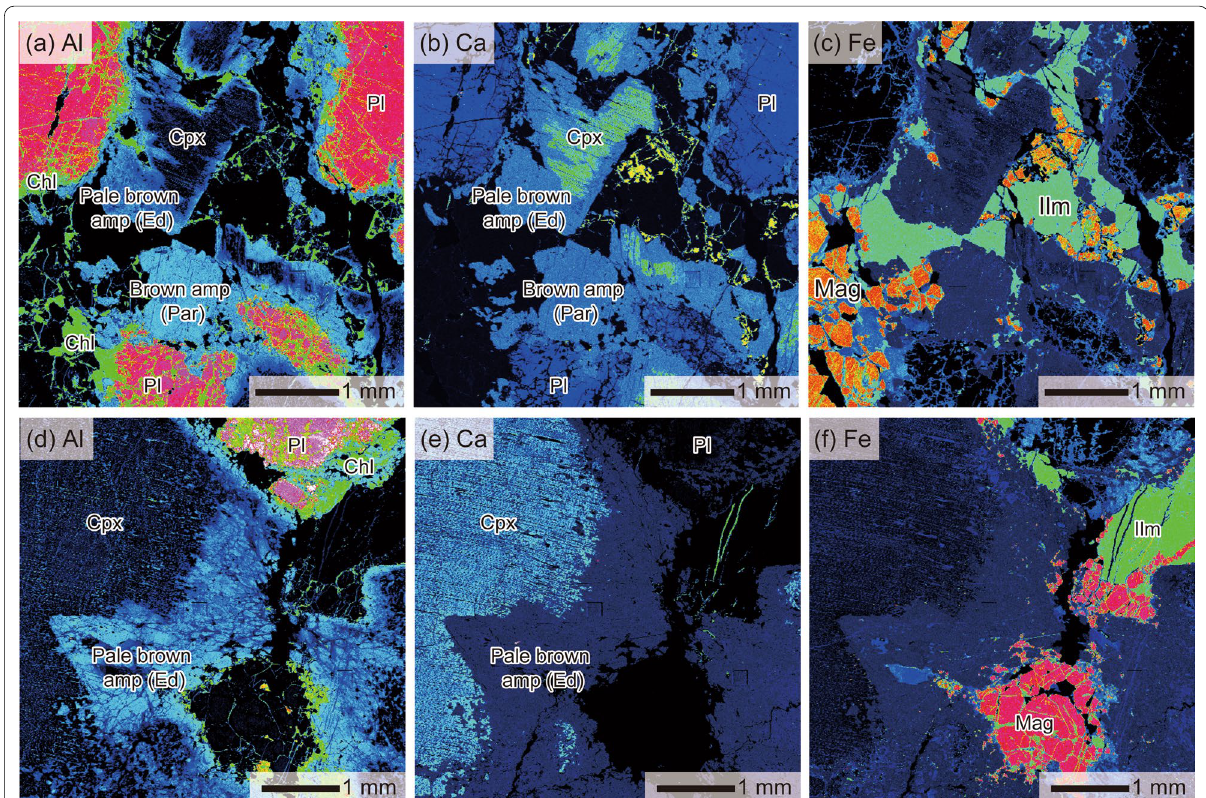
Fig. 4 Elemental distribution map of YK18‑07‑6K‑1515‑R14 oxide gabbro. Analytical areas are shown in Fig. 3b. An accelerating voltage of 15 kV, a probe current of 70 nA, a probe diameter of 1 μm, a stepping size of 9 µm, and measurement time of 80 ms were adopted for the elemental distribution map analyses by EPMA at AORI, the University of Tokyo. Abbreviations: Amp amphibole, Chl chlorite, Cpx clinopyroxene, = = = Ed edenite, Ilm ilmenite, Mag magnetite, Par pargasite, and Pl = = = = =